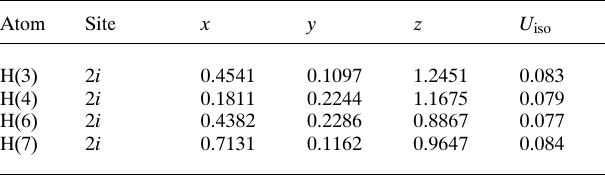
Table 2. Atomic coordinates and displacement parameters (in Å 2 ) . Table 2. Continued